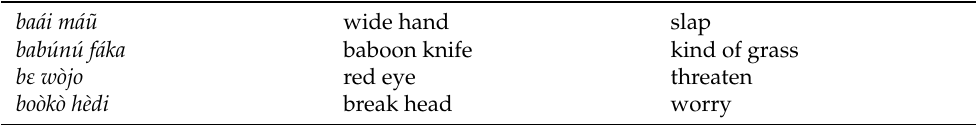
Table 4. Level Two compounding in Saramaccan